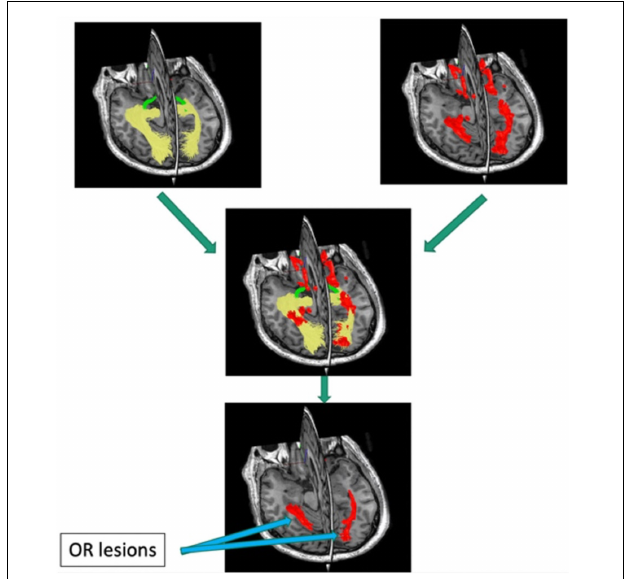
FIGURE 8 | Pipeline for detecting optic radiation lesions. Optic radiation (determined by tractography in yellow) is intersected with brain lesion mask